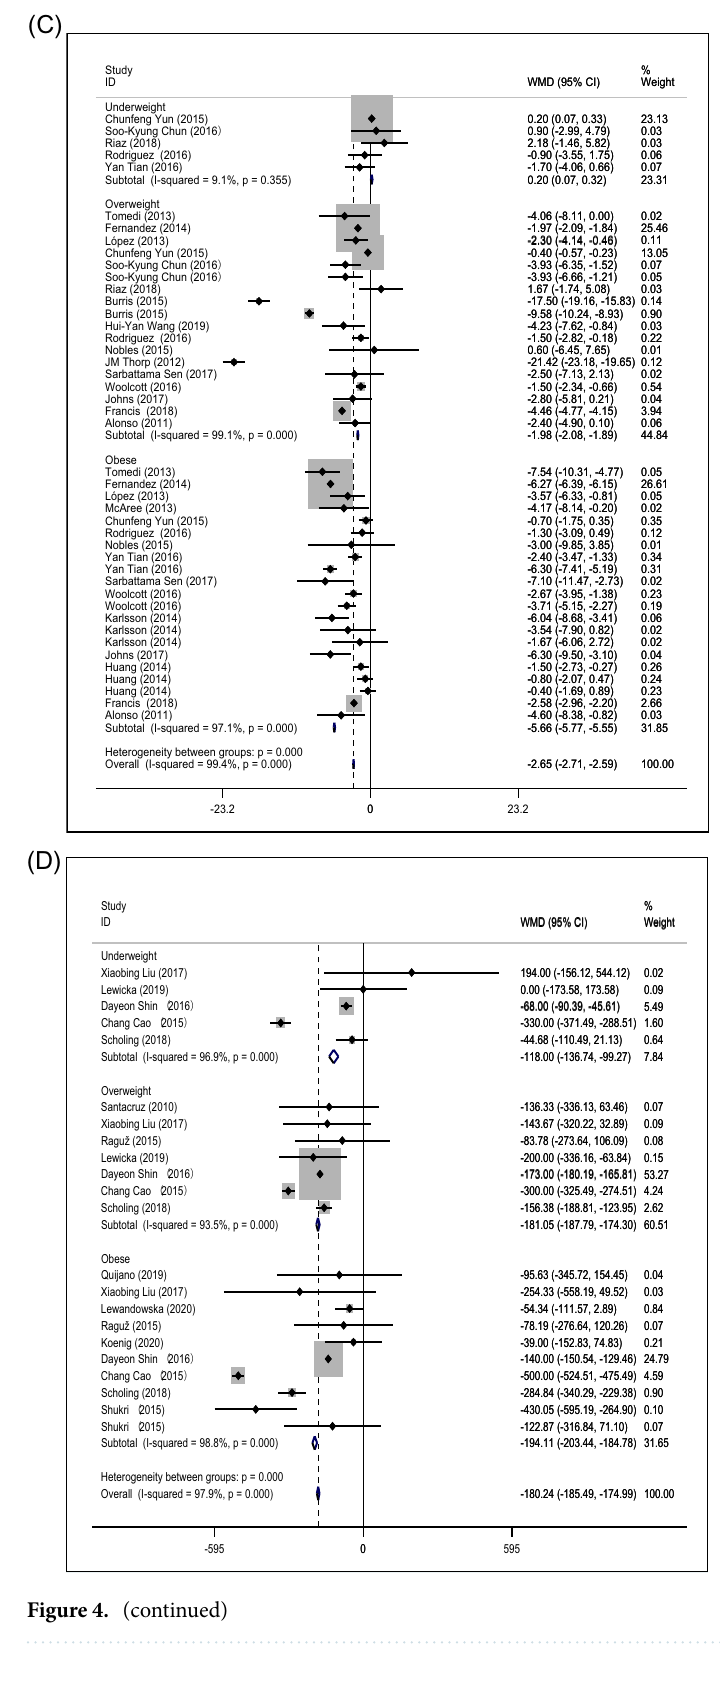
Heterogeneity between groups: p = 0.000 Overall (I-squared = 97.9%, p